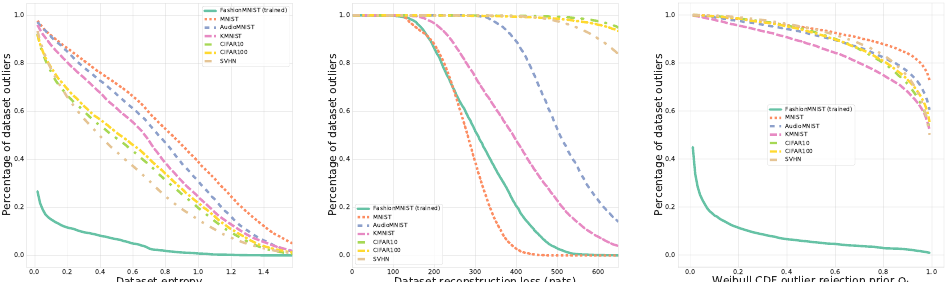
Figure 4. Model trained on FashionMNIST evaluated on unknown datasets. Robust classification of a known dataset (percentage of dataset outliers at 0%), while correctly flagging unknown datasets as outlying (percentage of dataset outliers at 100%), occurs when the solid green curve is separated from any of the colored dashed curves. ( Left ) Classifier entropy is insufficient to separate unknown from the known task’s test data. ( Center ) Reconstruction log-likelihood allows for a partial distinction. ( Right ) Our posterior-based EVT approach in OpenVAE considers the large majority of unknown data as statistical outliers across a wide range of rejection priors Ω t